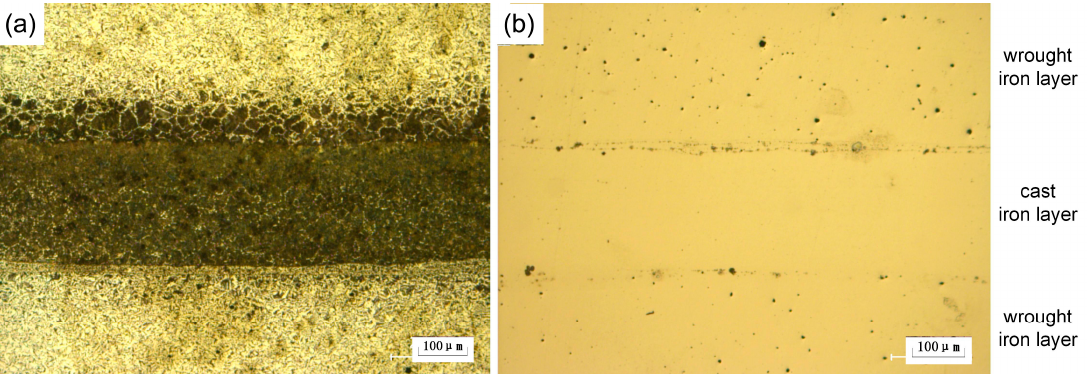
Figure 8. Distribution of inclusions in laminated co-fusion samples: ( a ) etching with 3 vol.% nitric acid for 5 s; ( b ) no etching.